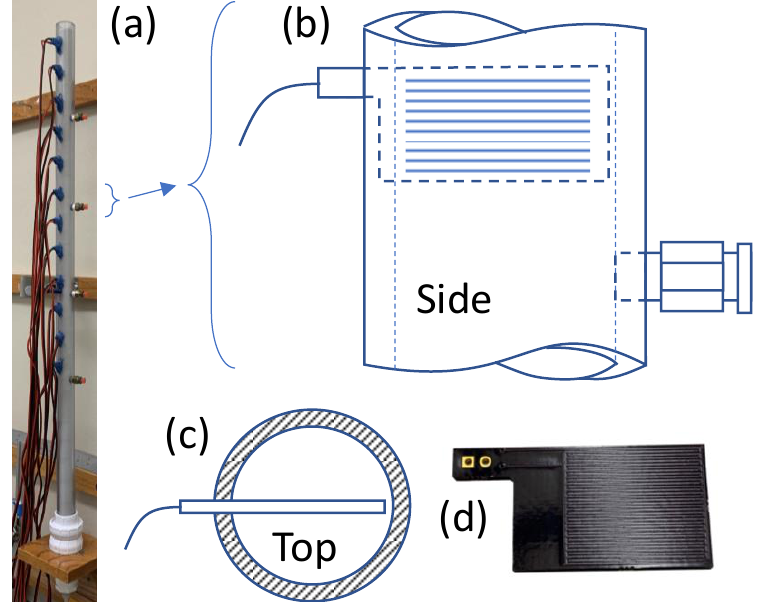
Figure 1. Column configuration used in this study. ( a ) The column; ( b ) Side view illustrating sensor and vent positioning; ( c ) Top view illustrating sensor positioning; ( d ) A custom interdigitated capacitive sensor of the kind used for this work.